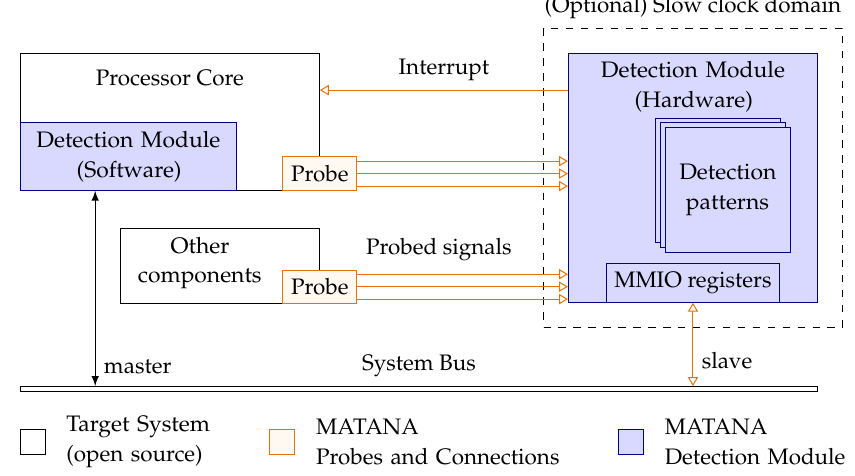
Figure 3. MATANA